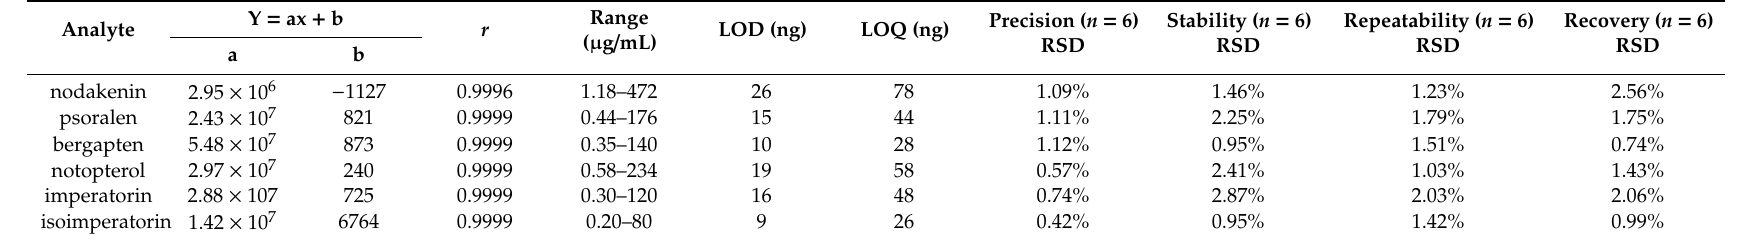
Table 1. Validation of quantitative method by UHPLC-PDA.